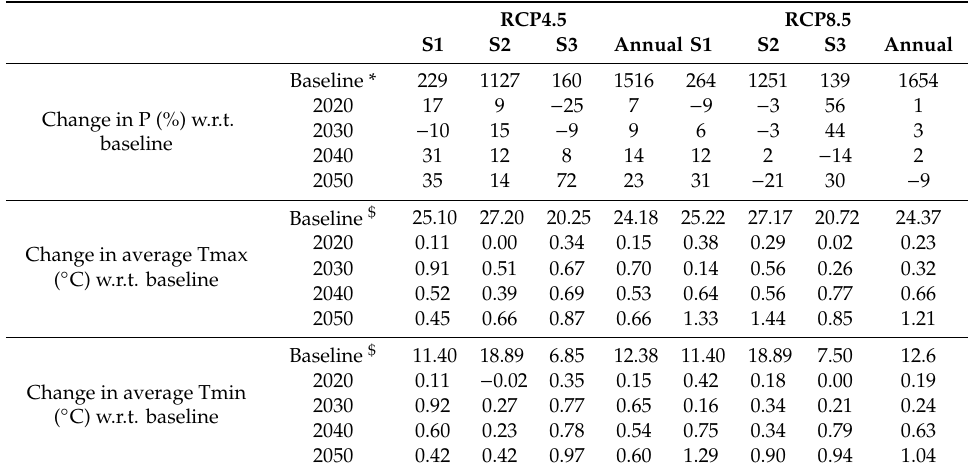
Table 2. Projected changes in precipitation and temperature with respect to (w.r.t.) baseline 2007–2014.